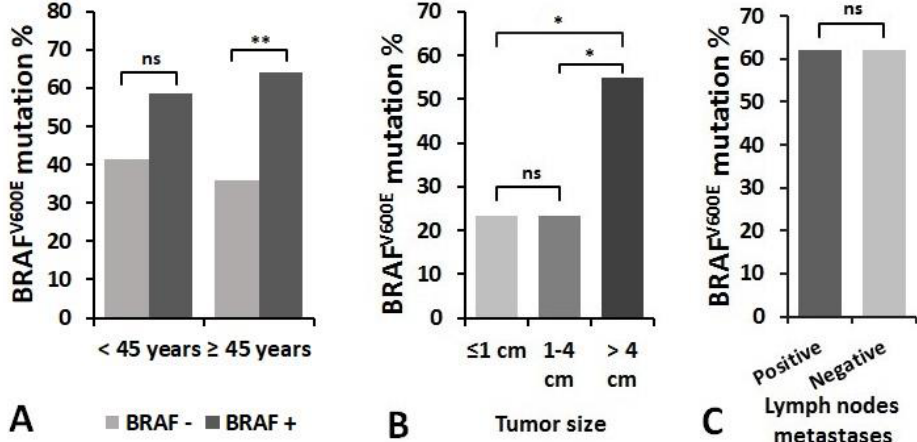
Figure 6. The relationship between the frequency of BRAF V600E mutation and clinicopathological features of PTC: ( A ) patient’s age at diagnosis, ( B ) tumor size, and ( C ) the presence of regional lymph node metastases at initial surgery. * p < 0.05, ** p < 0.01. ns—not significant. Table 2. Multivariate analysis of associations of PTC recurrence with prognostic factors. Binary logistic regression model was used. Odds ratios adjusted by gender and age categories (<45 years vs. 45 years).